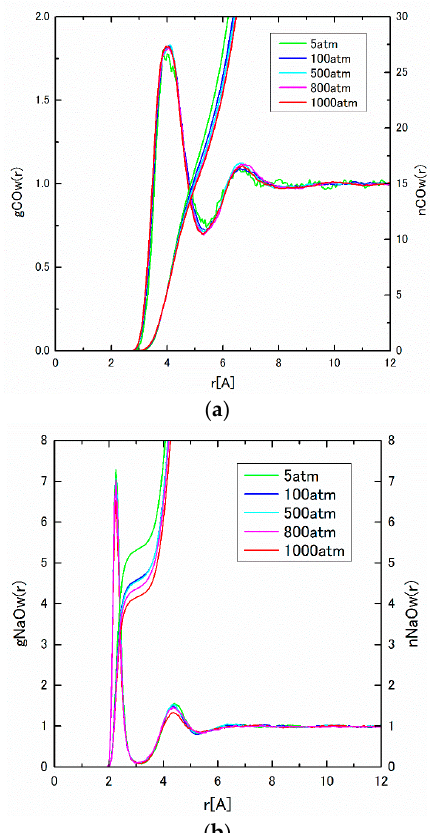
Figure 6. ( a ) g COw ( r ) and n COw ( r ) under pressures of 5–1000 atm; and ( b ) g NaOw ( r ) and n NaOw ( r ) under pressures of 5–1000 atm.